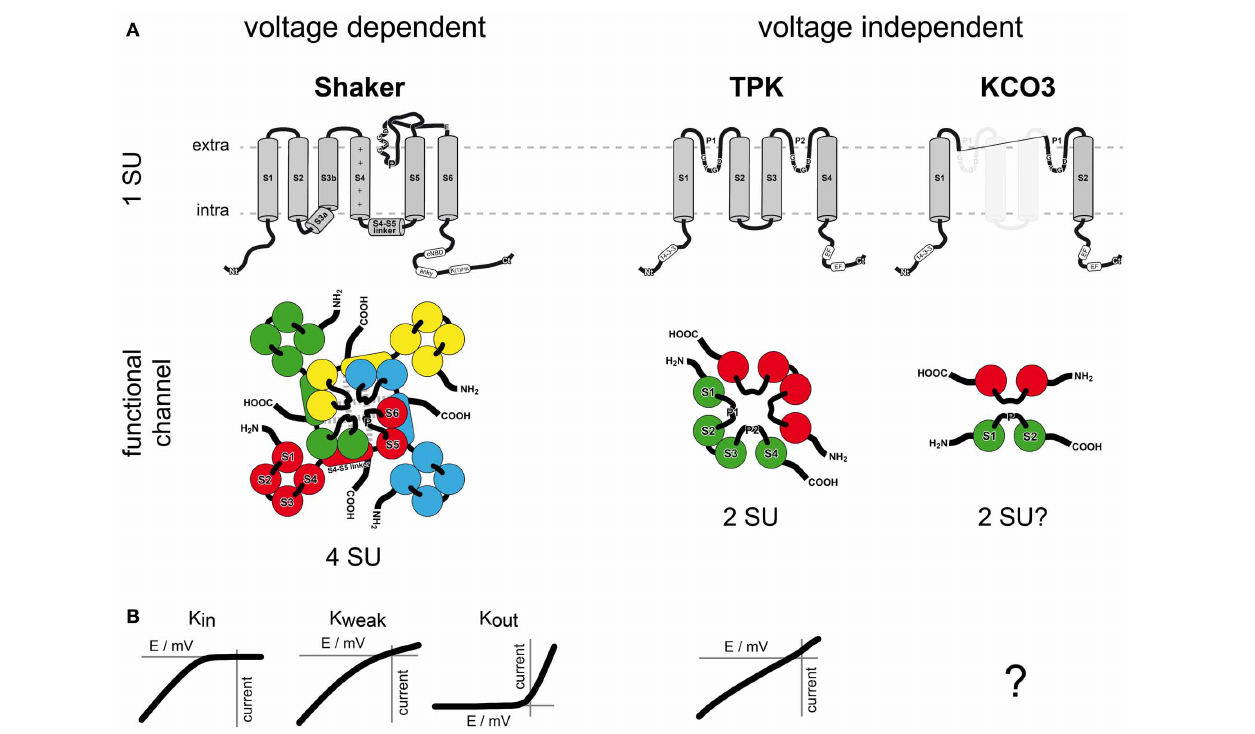
FIGURE 1 | Structure and function of K + channel families in plants. The two plant K + channel families vary in (A) structure and (B) function. Shaker channels form the most versatile family among plant K + channels. Nine members segregate into inwardly, outwardly and weakly rectifying channels. Functional channels are tetramers and operate in a voltage dependent manner. One subunit consists of six transmembrane domains (S1–S6) and one pore domain (P). The fourth transmembrane region S4 is rich in positively charged amino acids and acts together with S1, S2, and S3 as voltage sensor. Five TPK channels have been identified. One subunit contains two pore domains (P1 and P2) and two subunits are sufficient to form a functional